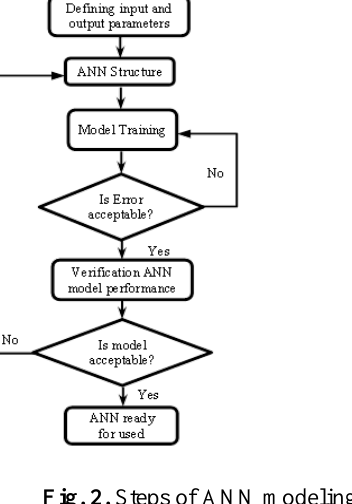
Fig. 2. Steps of ANN modeling Fig. 3. Architecture for the ANN